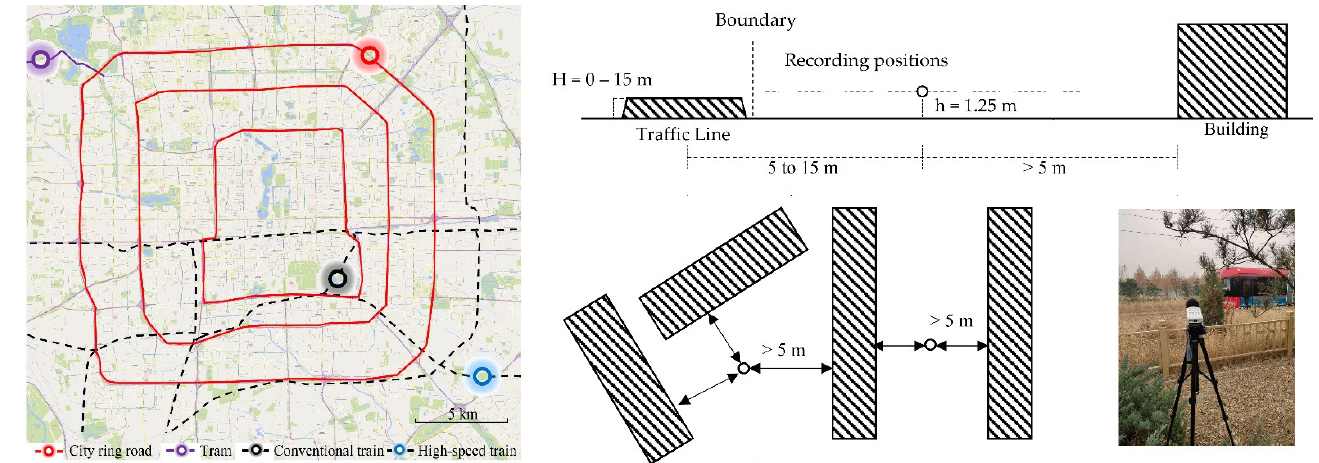
Figure 2. Site and implementation of field recording.